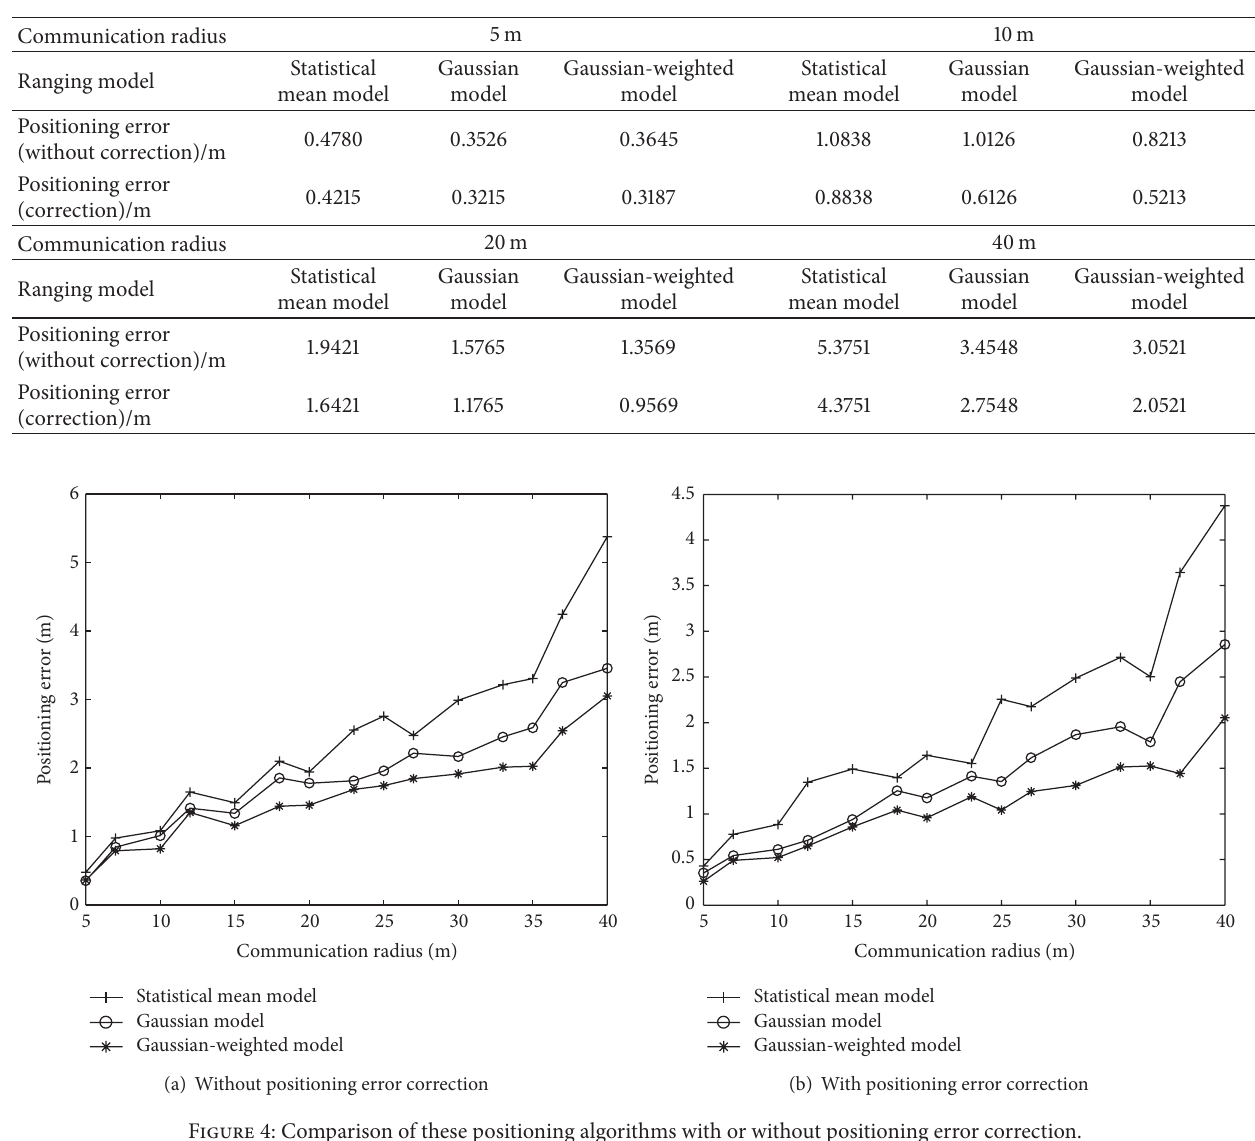
Figure 4: Comparison of these positioning algorithms with or without positioning error